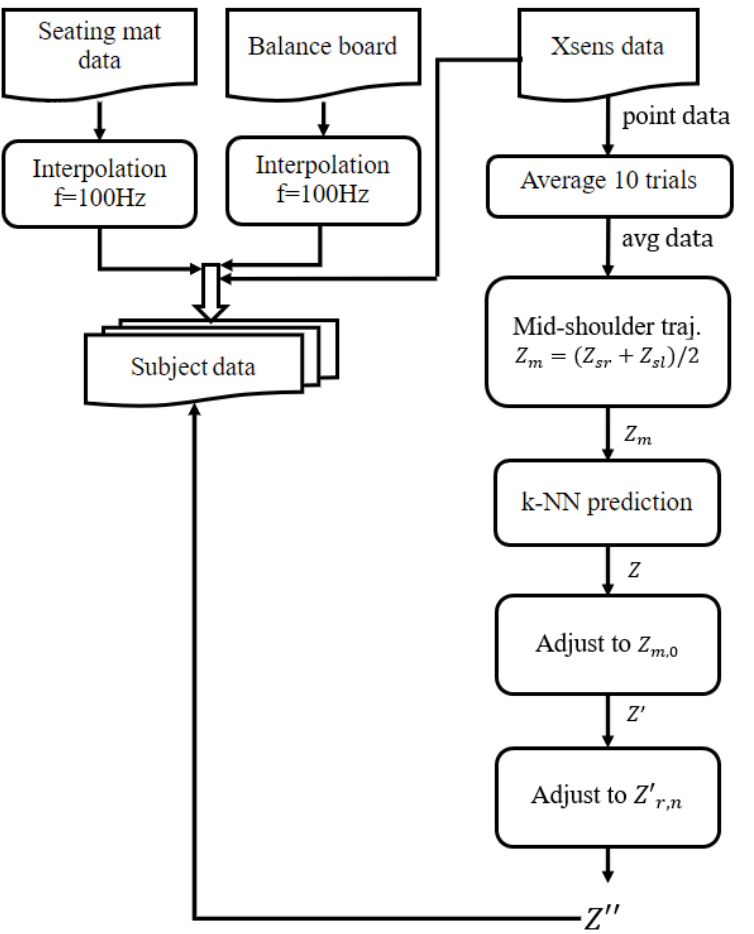
Figure 3. Flow chart depicting data processing and trajectory prediction for each